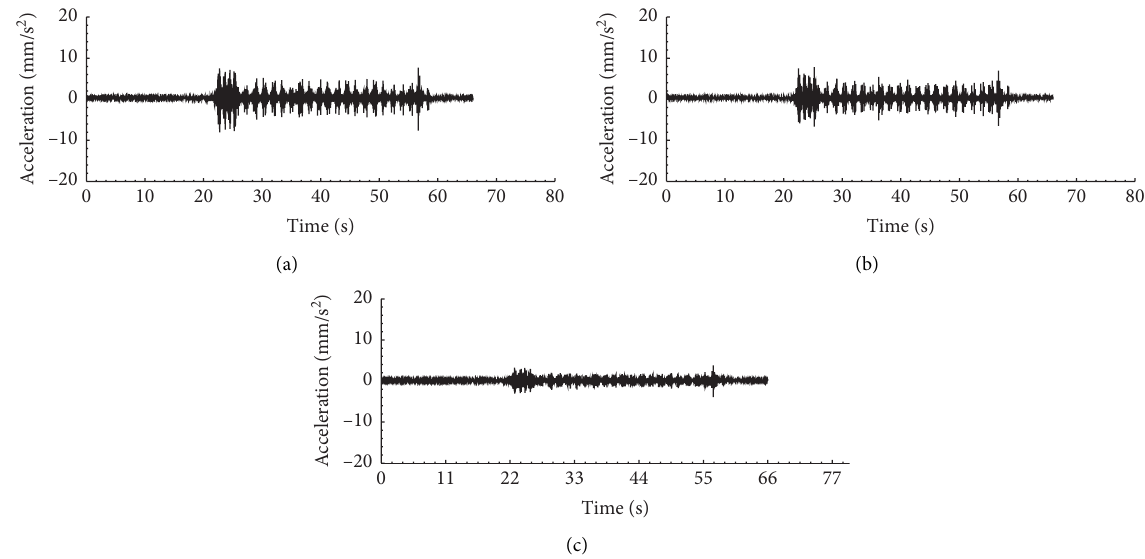
Figure 9: Time-domain curves of vibration acceleration of C2 measuring point before subgrade reinforcement-truck in different directions: (a) Z direction. (b) Y direction. (c) X